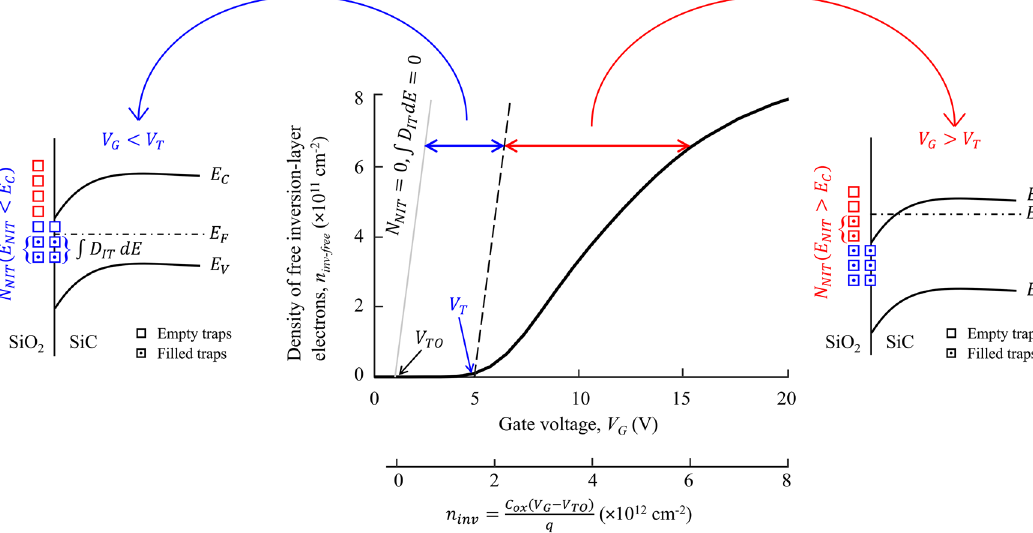
Figure 1. Illustration of the effects of interface- and near-interface traps with energy levels below the bottom of the conduction band ( E NIT < E C ), shown with the blue symbols, and near-interface traps with energy levels above the bottom of the conduction band ( E NIT > E C ), shown with the red